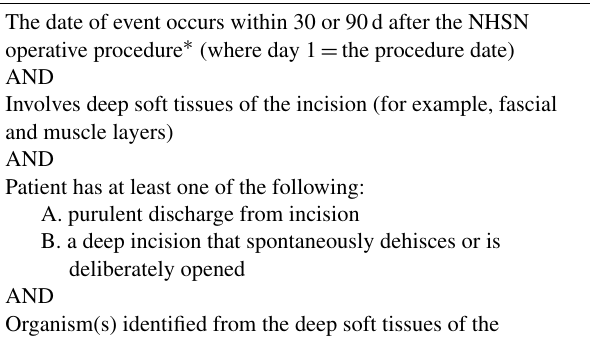
Table 1. CDC/NHSN definition of deep surgical site infection. Table 2. Annual number of confirmed deep surgical site infection cases within 90d of surgery between January 2013 and March